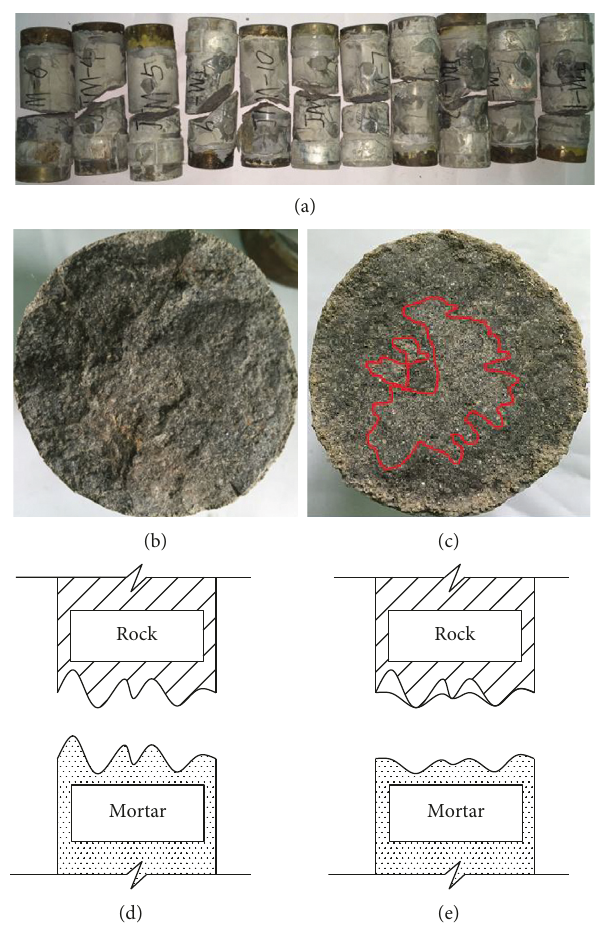
Figure 9: Sectional shape under different strain rates. (a) After damage of rock-mortar-interface specimens; cross sections of strain rates (b) 10 − 6 s − 1 and (c) 10 − 4 s − 1 ; and schematic cross sections of strain rates (d) 10 − 6 s − 1 and (e) 10 − 4 s − 1